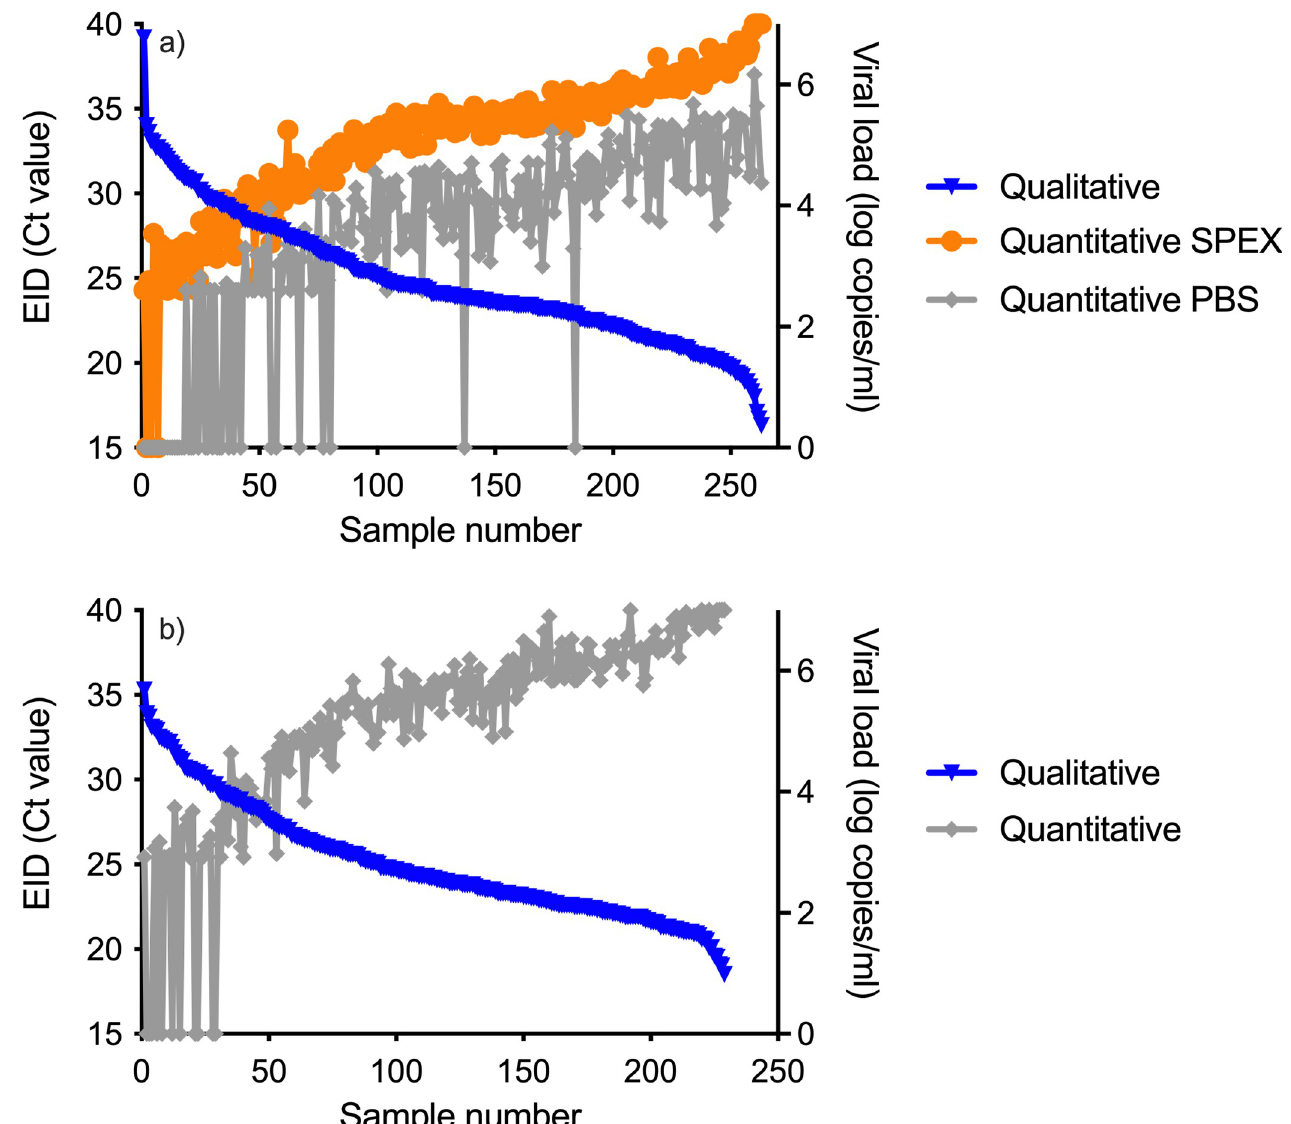
Fig 2. Qualitative cycle threshold values of qualitative and quantitative viral loads for both Roche protocols (a) and Abbott (b).